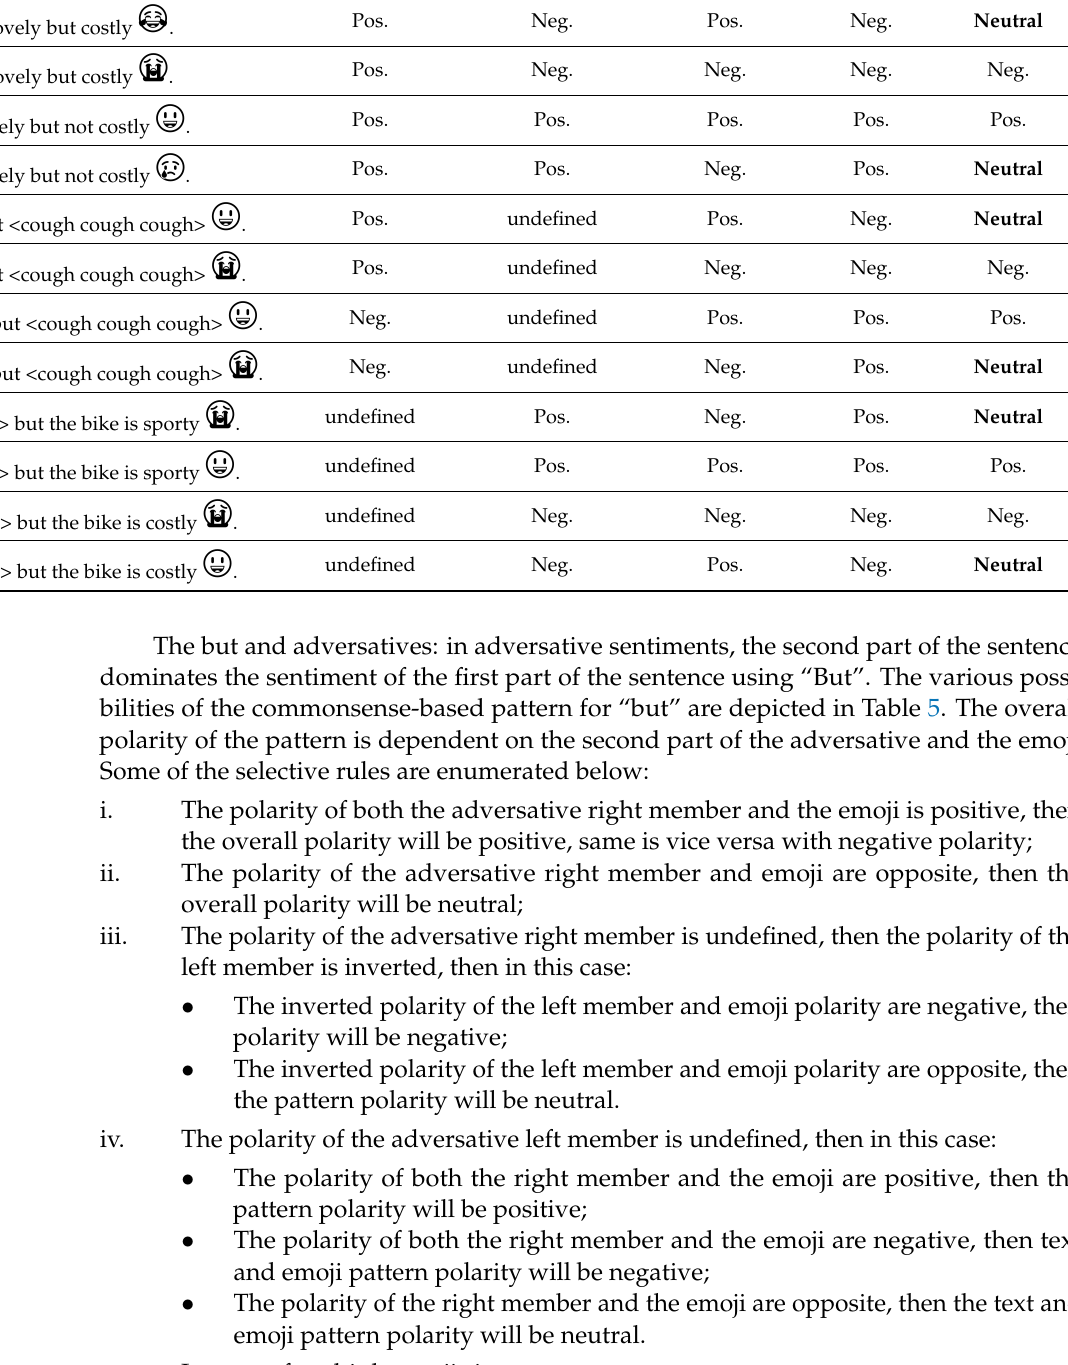
Table 5. But and adversatives pattern.